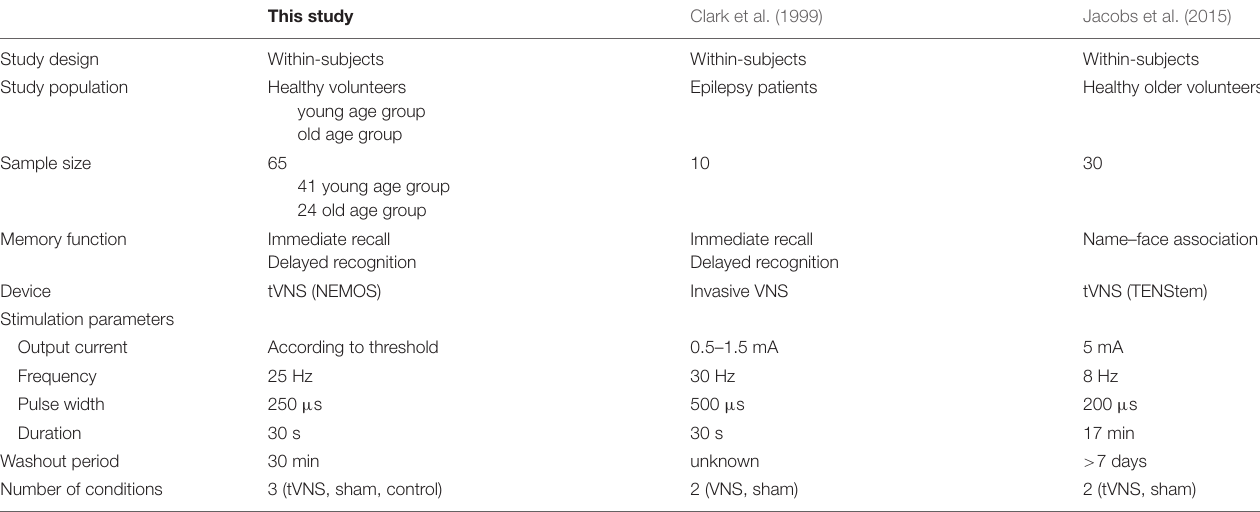
TABLE 1 | Overview of study characteristics of this clinical study and previous research investigating the effect of VNS on memory performance. This